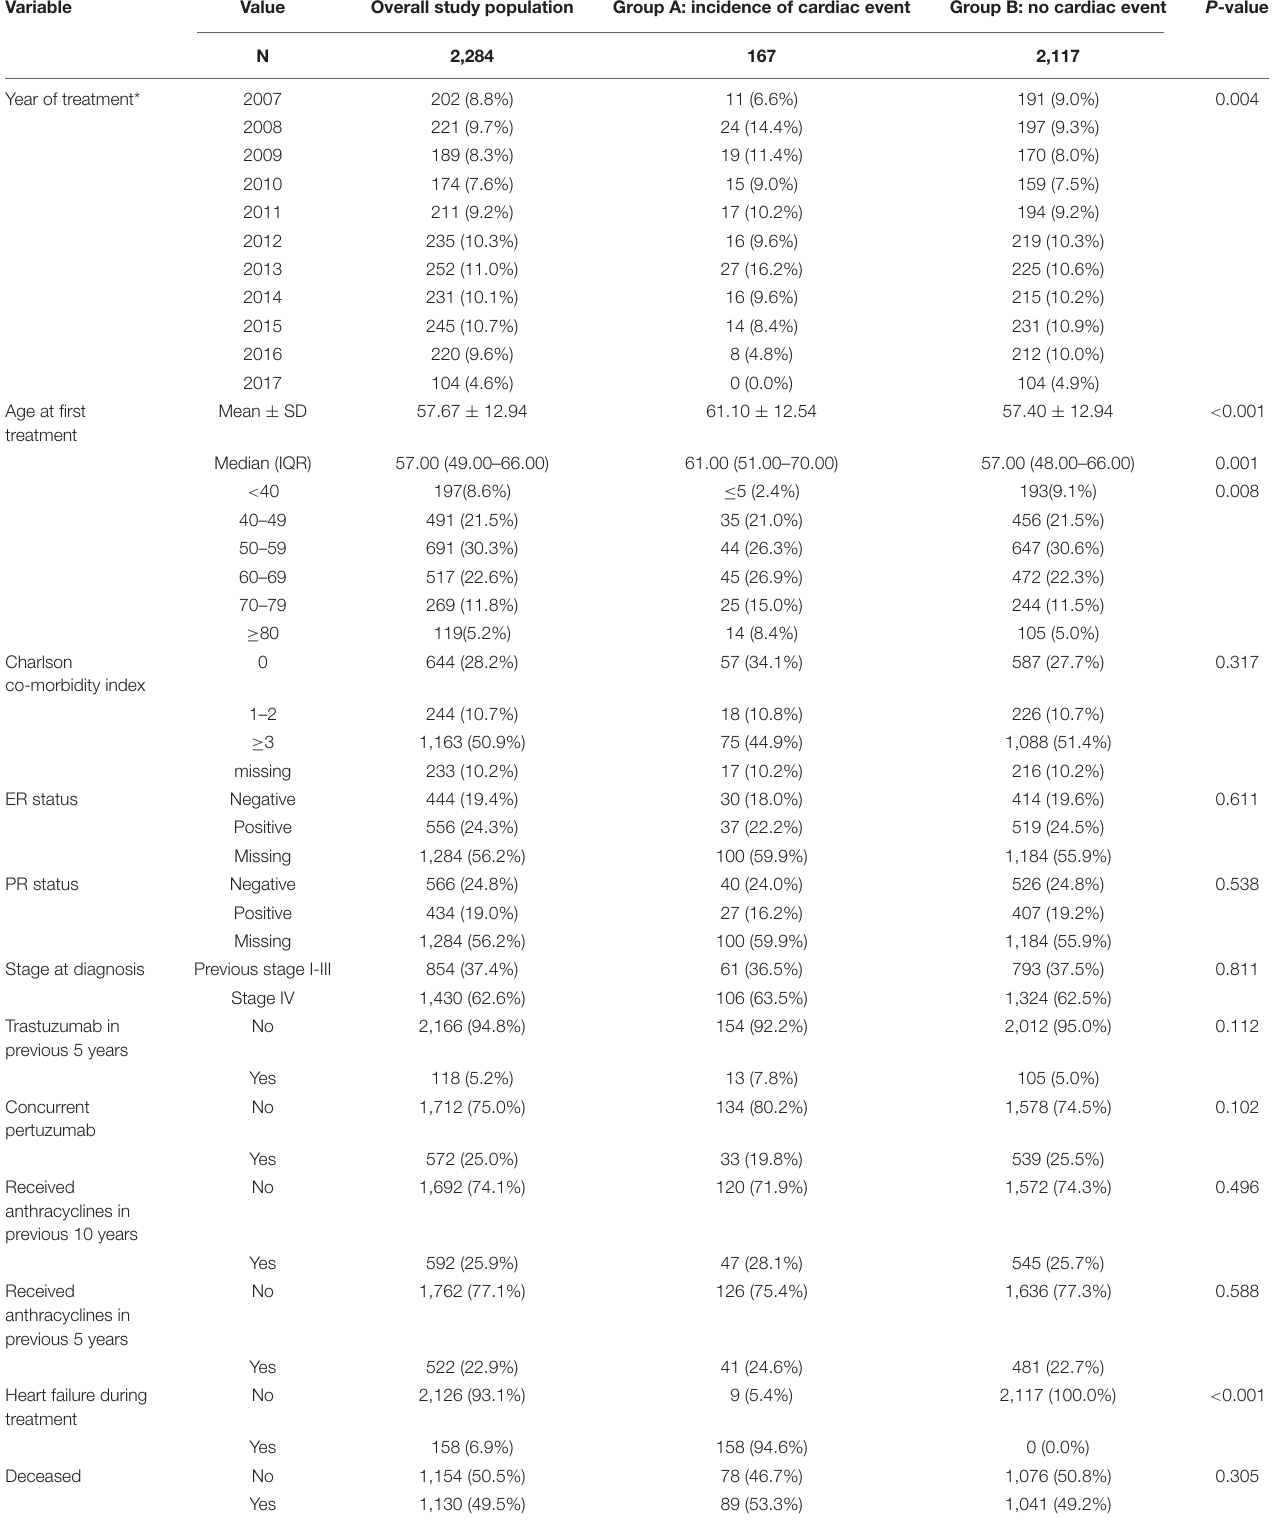
TABLE 1 | Baseline